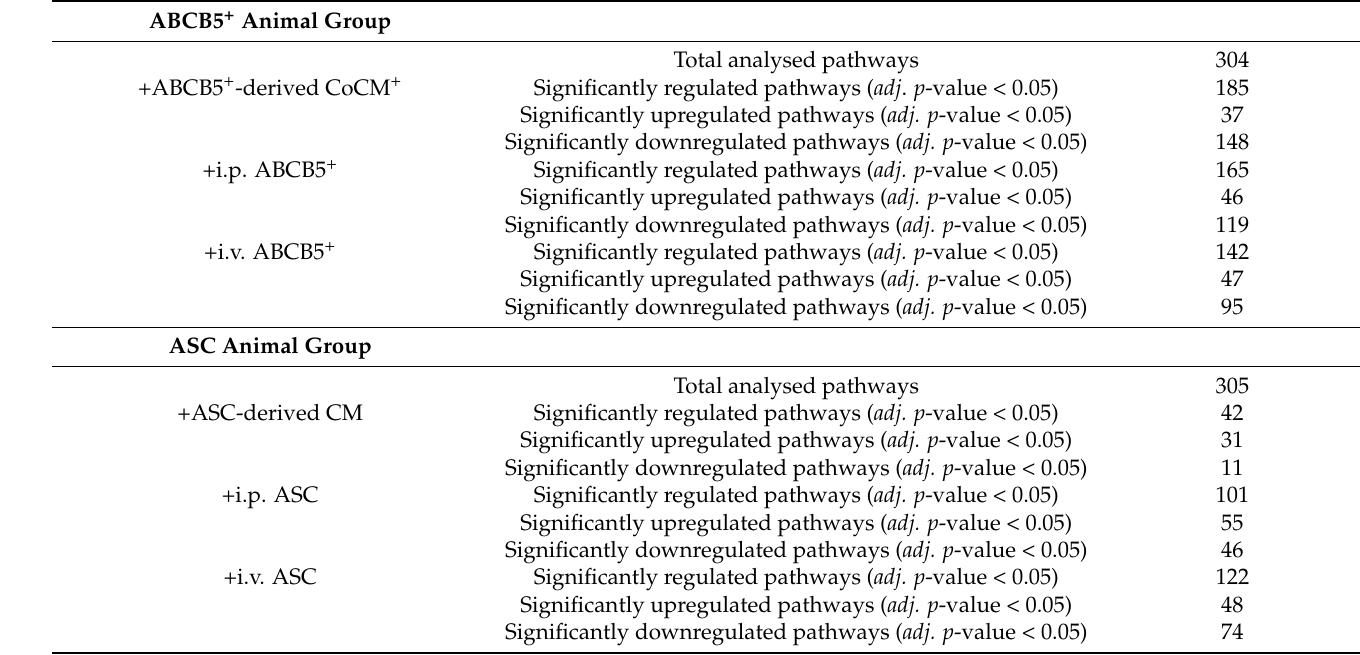
Table 1. GSEA pathway analyses showing the numbers of up- and downregulated pathways in PKD/Mhm (Cy/+) groups (n = 6 in each group). (A) ABCB5 + -derived CoCM + ; i.p. ABCB5 + ; i.v. ABCB5 + ; (B) ASC-derived CM; i.p. ASC; i.v. ASC. Total analysed pathways are 304 in the ABCB5 + - derived CoCM + ; i.p. ABCB5 + ; i.v. ABCB5 + groups while 305 in the ASC-derived CM; i.p. ASC; i.v. ASC groups because GSEA analyses were performed in two different